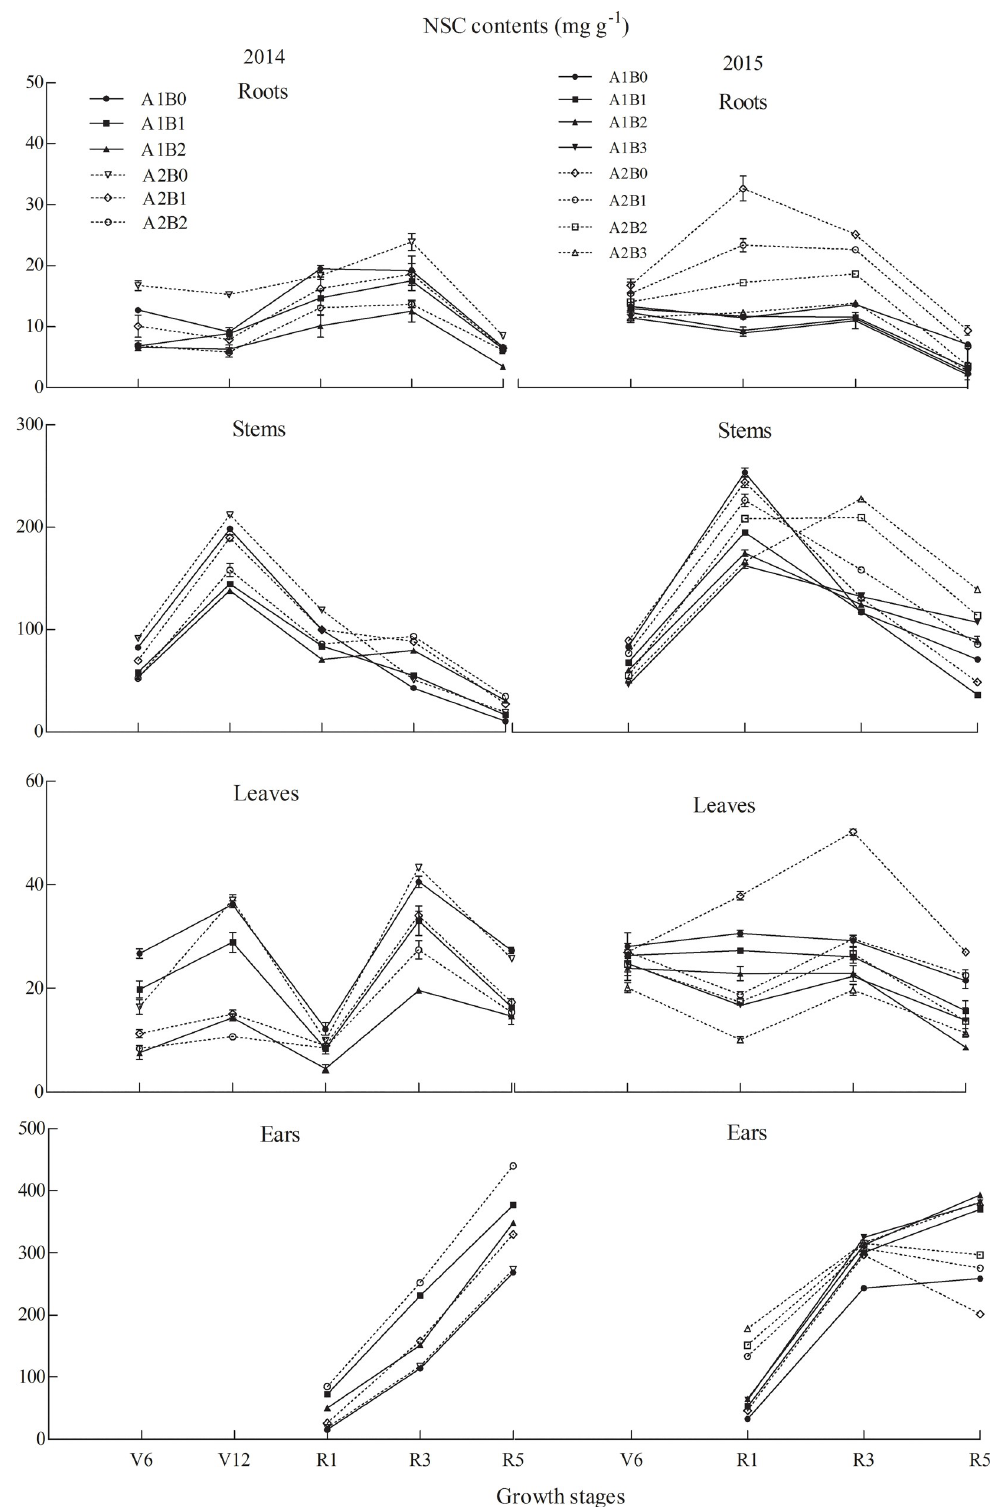
Fig 5. Starch content in different growth periods of maize under various treatments. Note: V6, jointing (V6); V12, big trumpet; R1, silking (R1); R3, milk-ripe; and R5, maturity. A stands for cultivars: A1, ZH311; A2, XY508. B stands for N treatments: B0, 0 kg � ha -1 ; B1, 150 kg � ha -1 ; B2, 300 kg � ha -1 ; and B3, 450 kg � ha -1 .The point in R5 indicates soluble sugar content in grains. https://doi.org/10.1371/journal.pone.0225753.g005 PLOS ONE | https://doi.org/10.1371/journal.pone.0225753 December5,